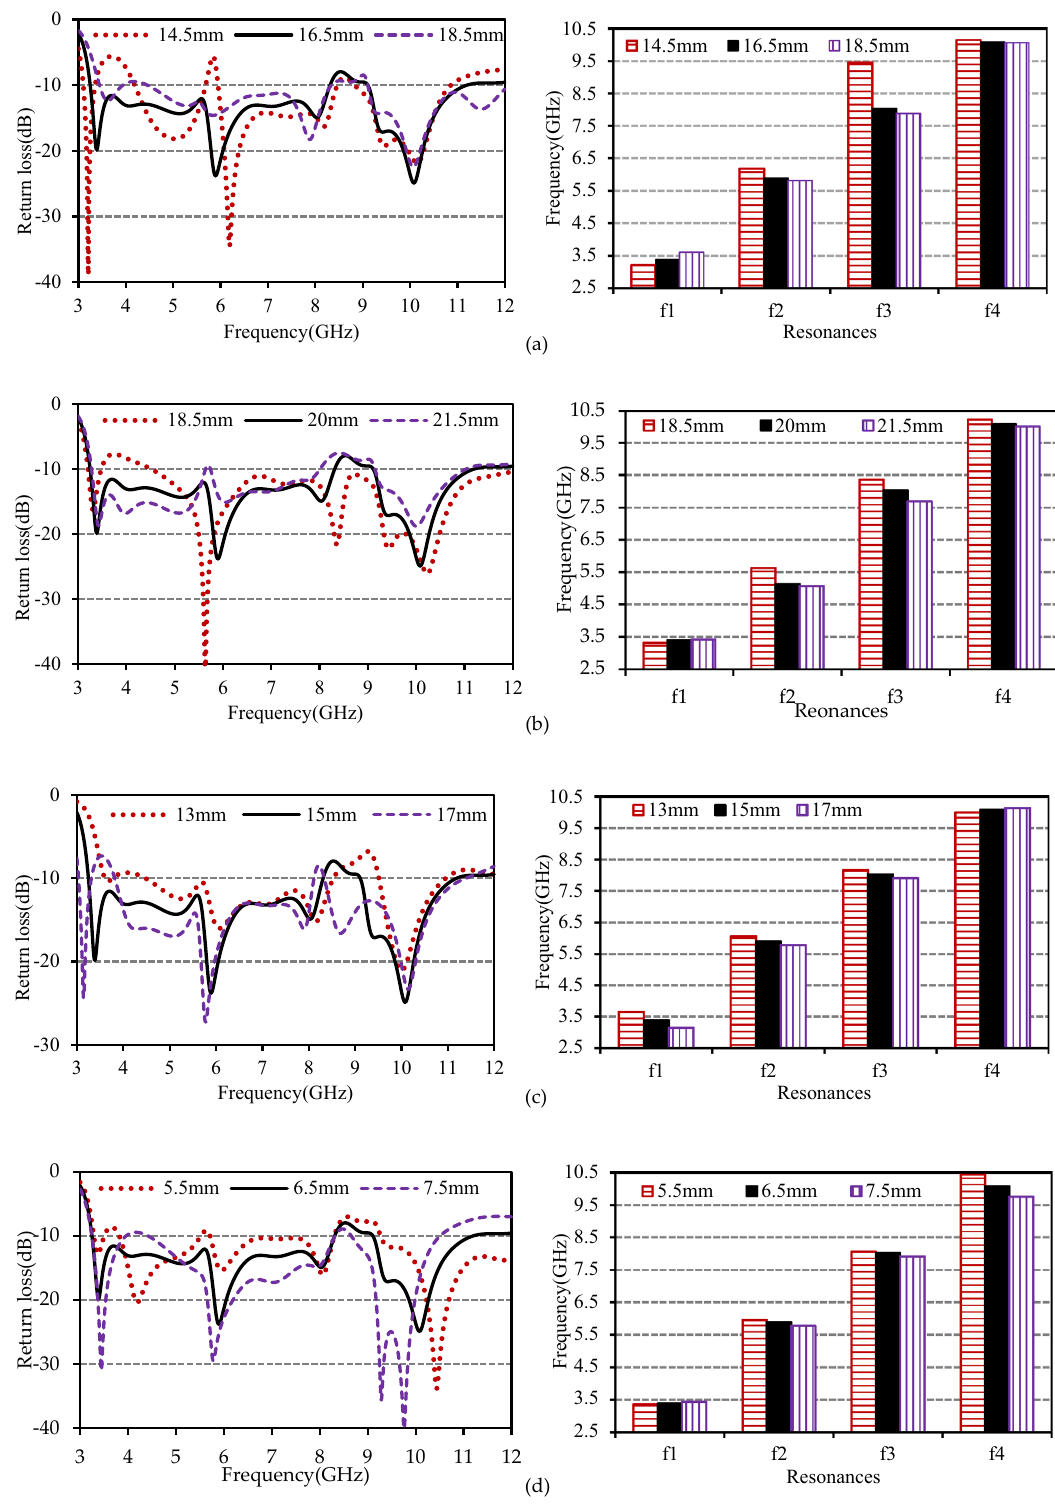
Figure 6. ( a ) Effect of W 1 on return losses and resonance frequencies, ( b ) effect of L 1 on return losses and resonance frequencies, ( c ) effect of L 6 on return losses and resonance frequencies, ( d ) effect of L f1 on return losses and resonance frequencies, ( e ) effect of H on return losses and resonance frequencies, and ( f ) effect of d on return losses and resonance